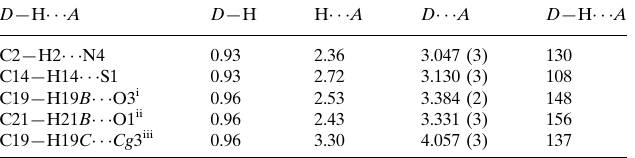
Hydrogen-bond geometry (A˚ , (cid:1) ). D —H (cid:2)(cid:2)(cid:2)